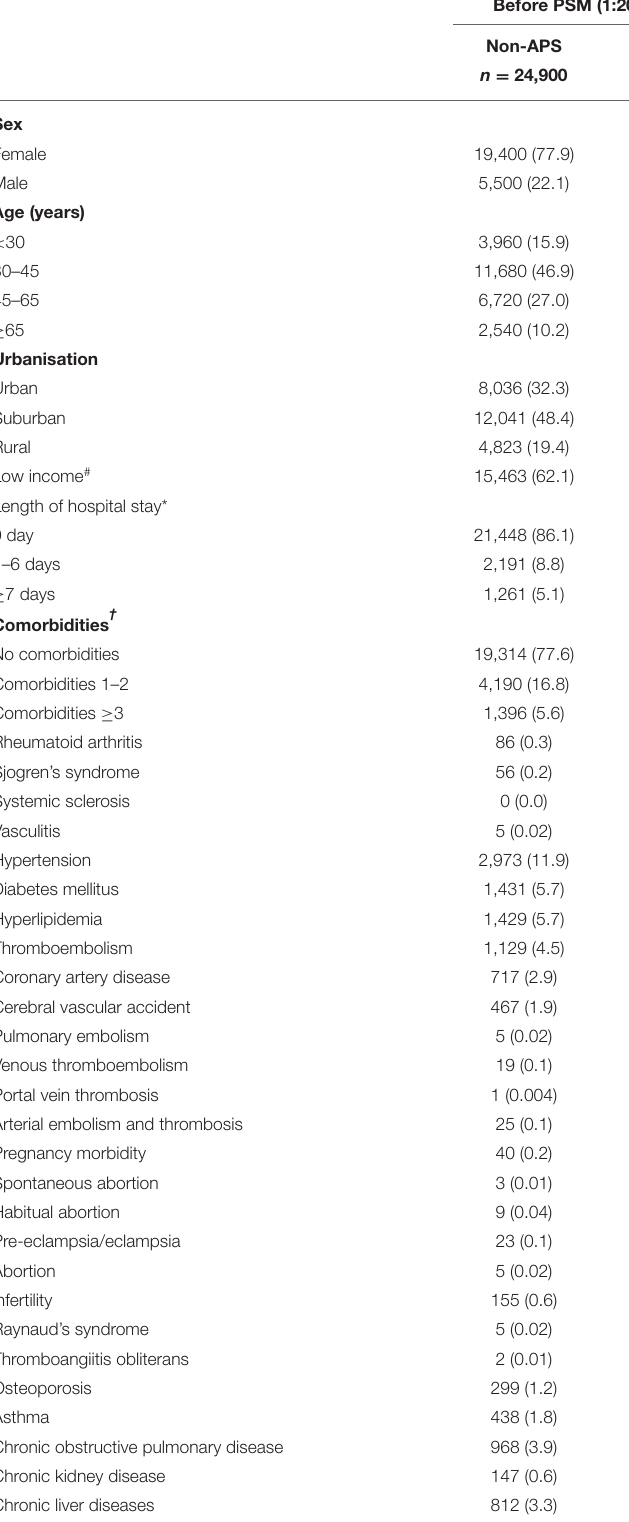
Before PSM (1:20 age–sex